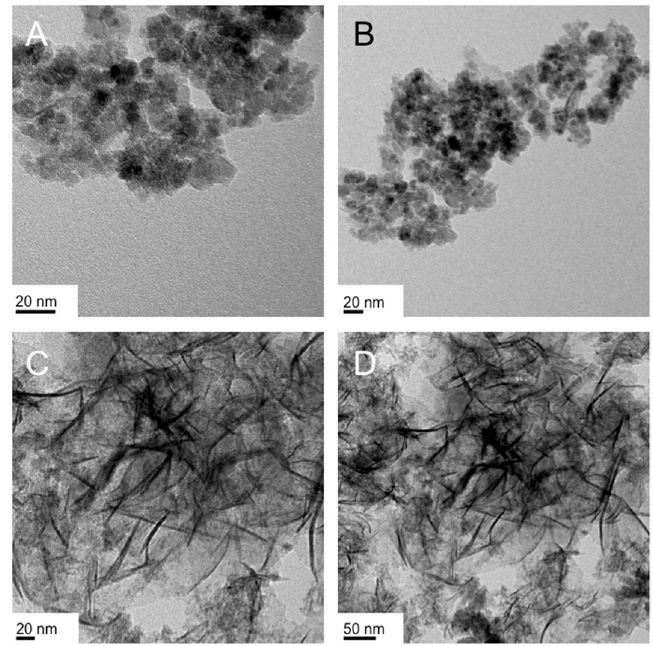
Figure 5. TEM images of the IO nanostructures obtained from the synthesis in the L α phase formed by Brij-C10 (72.5 wt %) in water at 62 °C: ( A , B ) froth fraction and ( C , D ) gel fraction.